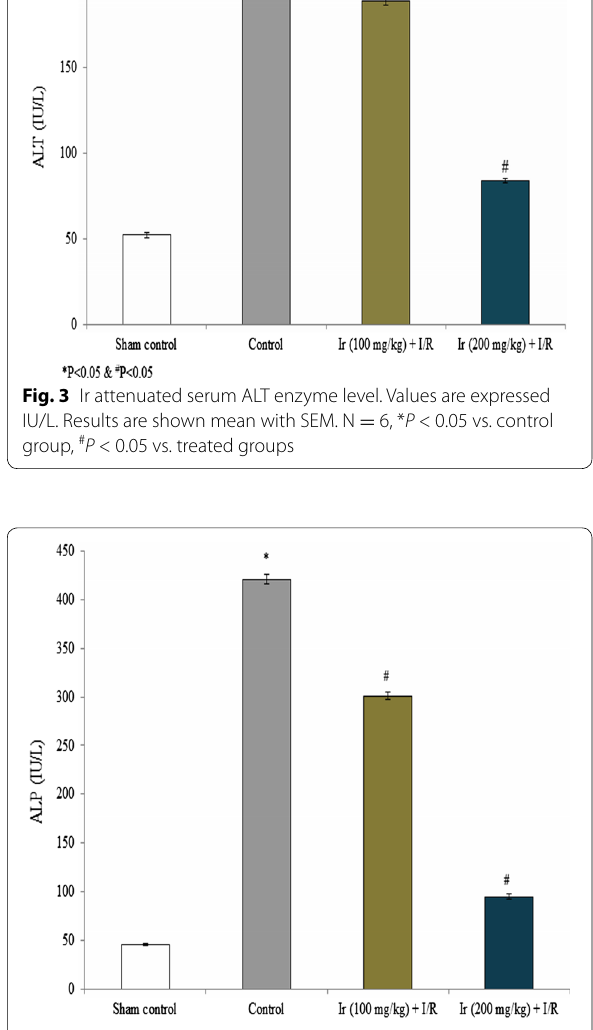
6, * P < 0.05 vs. control =